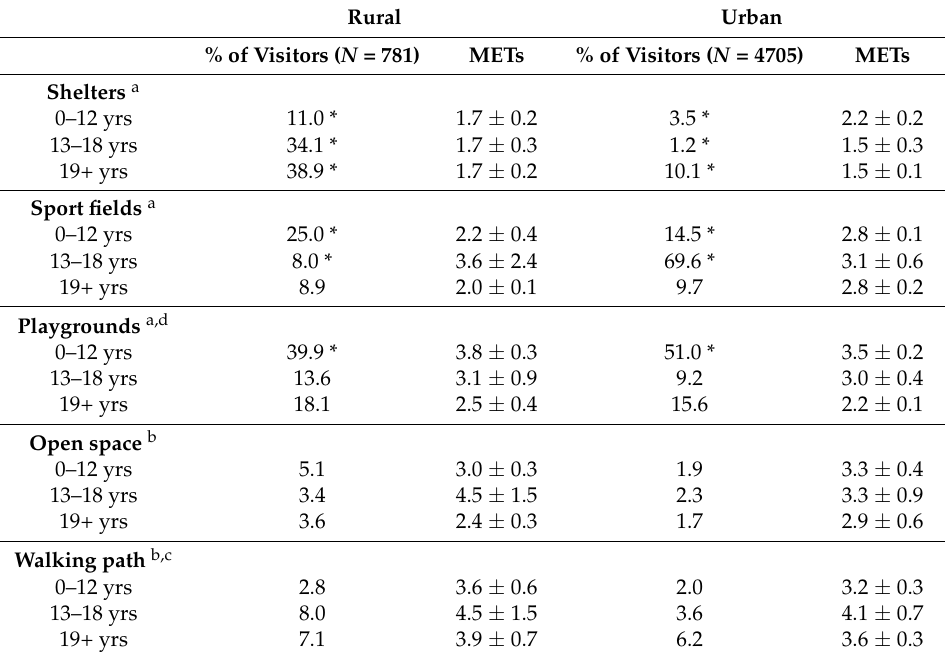
Table 5. Percentage of visitors engaged in activities and MET intensity of those activities by age group at rural or urban